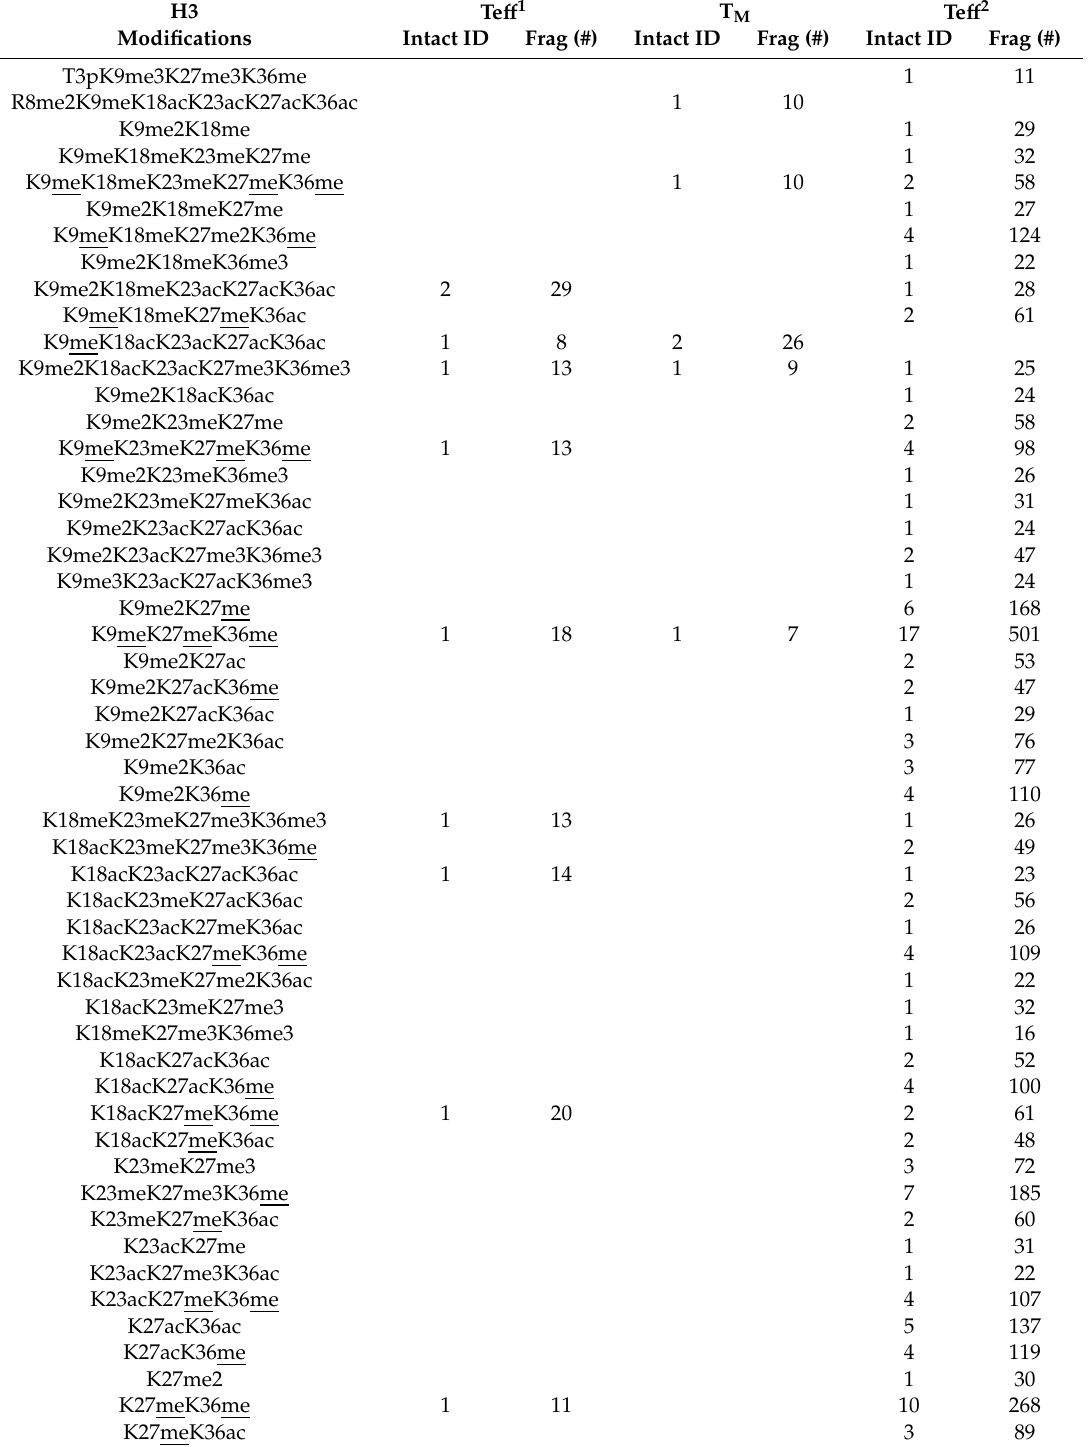
Table 4. H3 modifications from Te ff 1 , T M , and Te ff 2 after influenza